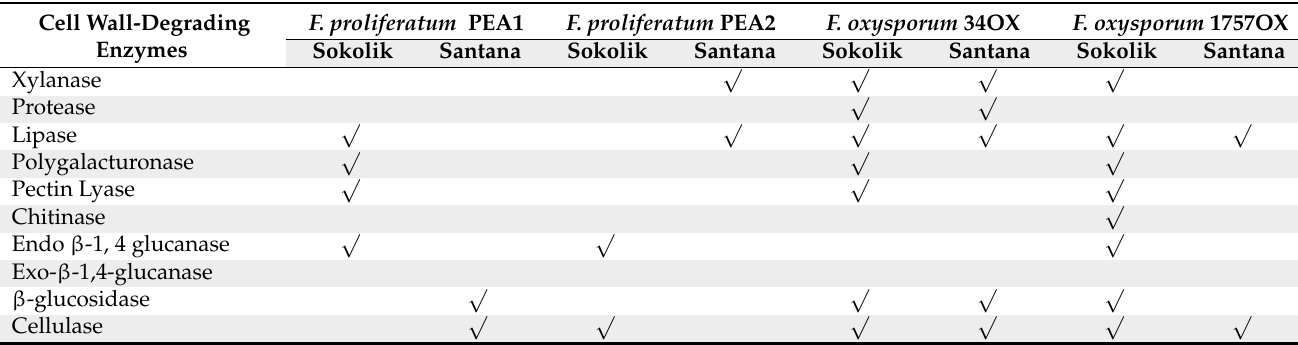
Figure 9. Cellulase activity obtained from the roots and soil of Sokolik and Santana infected with PEA1, PEA2, 34OX and 1757OX and the control calculated from triplicate treatments. Error bar represents the standard error. * Statistically significant ( p < 0.05). Table 1. Major enzymes produced by F, proliferatum (PEA1 and PEA2) and F. oxysporum (34OX and 1757OX) upon interaction with resistant (Sokolik) and susceptible (Santana) pea